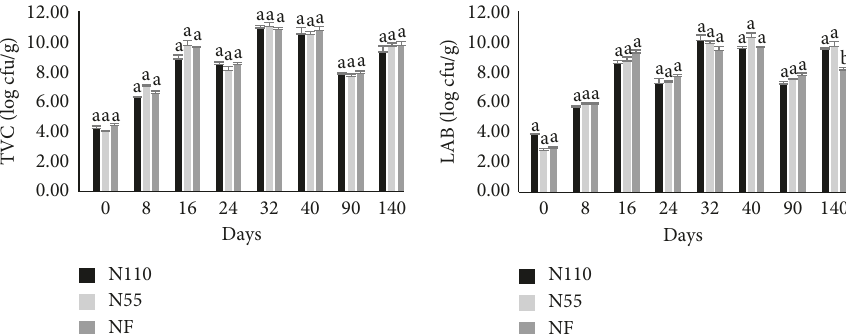
Figure 3: Influence of sodium nitrite reduction on number (log cfu/g) of total viable count (TVC) and lactic acid bacteria (LAB) during ripening and storage of kulen (mean ± standard deviation). Values followed by different letters (a–b) differ significantly ( P < 0 .